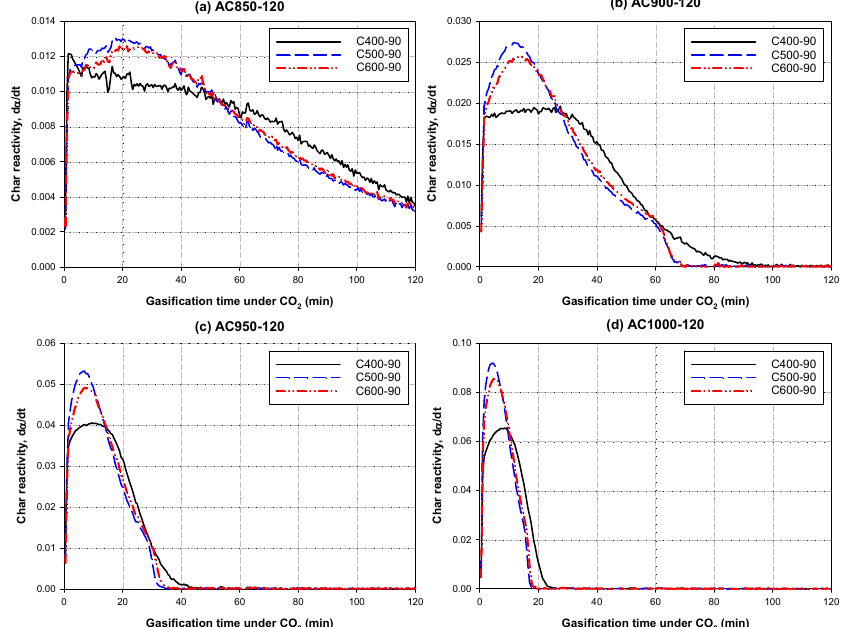
Figure 9. Variation of char reactivity during CO 2 gasification as a function of time for various chars and activation temperatures. Lines with black, blue, and red colors represent chars prepared at 400, 500, and 600 °C, respectively, with each char being gasified at ( a ) 850 °C, ( b ) 900 °C, ( c ) 950 °C, and ( d ) 1000 °C for 120 min.